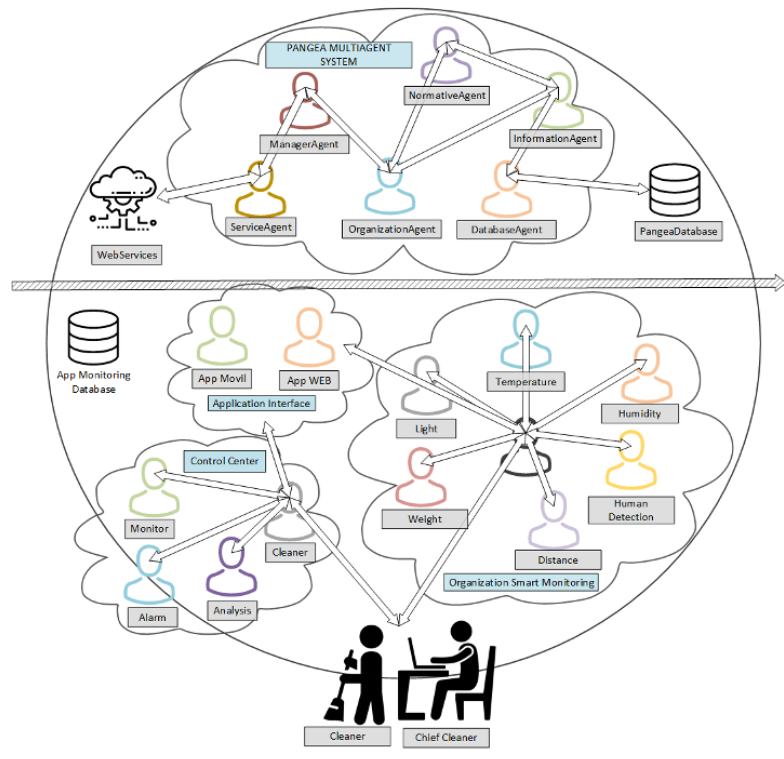
Figure 1. Multi-agent architecture of system based in MAS